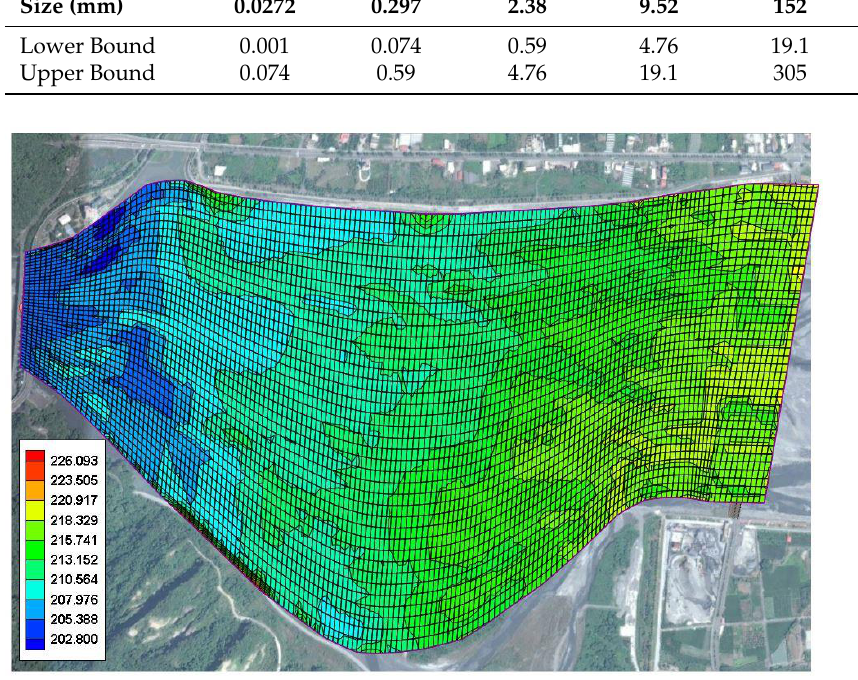
Figure 13. Initial bed elevations and computational mesh for the JiJi Reservoir with 6440 nodes and 6240 cells.